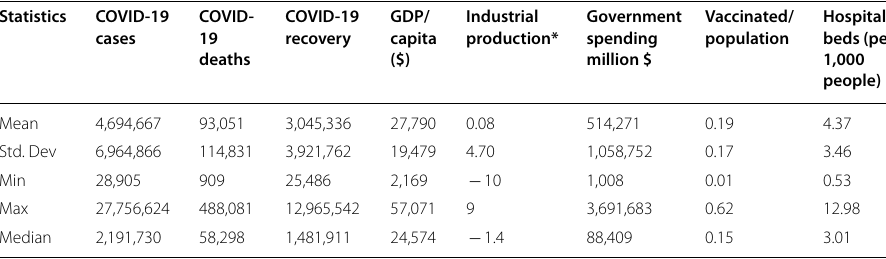
Table 3 Statistics for the considered variables